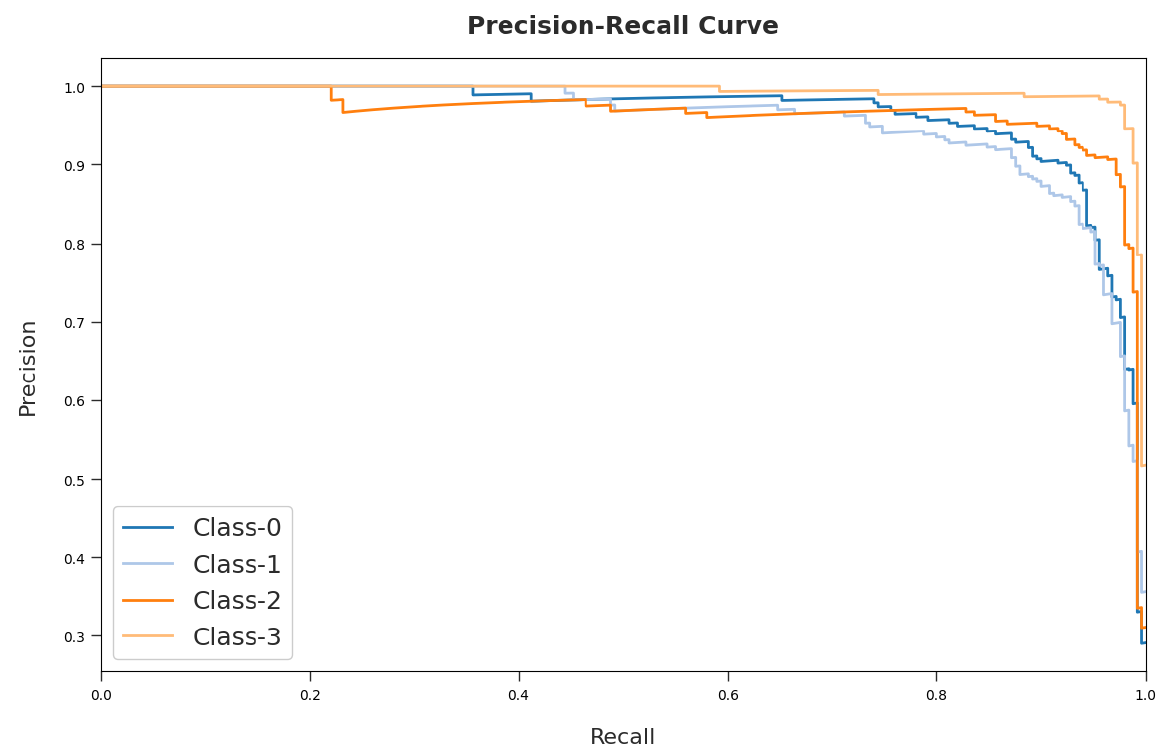
Figure 9. Precision-recall curve analysis of MDTL-ICDDC technique.